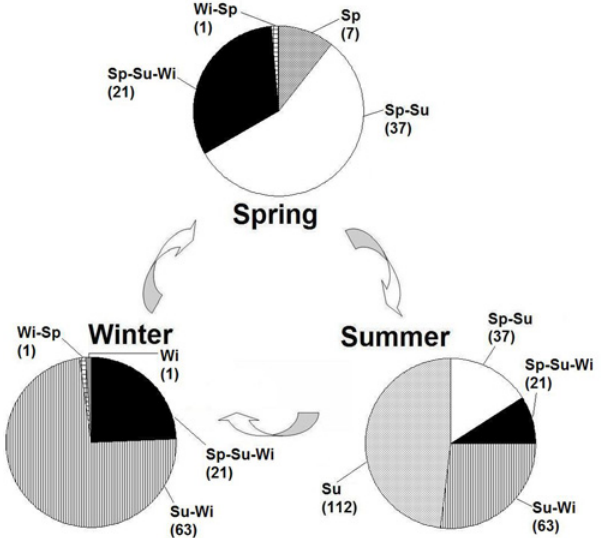
Fig 2. Seasonal host switching of Apolygus lucorum among different plant species at Langfang (Hebei Province, Northern China). Sp-Su-Wi refers to species of host plants through spring, summer and winter seasons. Sp-Su and Su-Wi are host plants in both spring and summer, and both summer and winter, respectively. Sp, Su and Wi are those only in spring, in summer and in winter, respectively. Data between brackets refer to the number of corresponding host plant species.